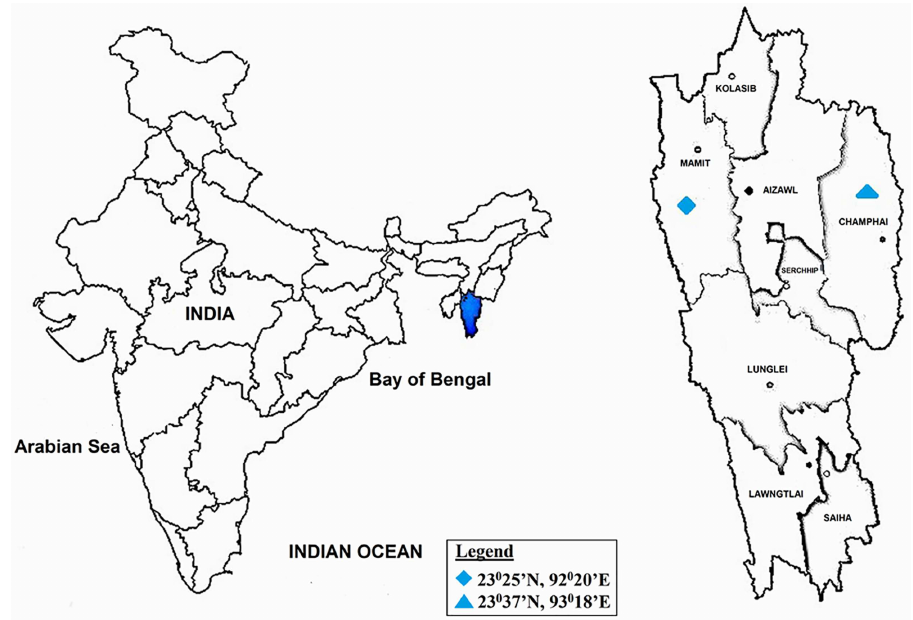
Fig 1. Map revealedthe locations of the Sub-tropical Semi-evergreen forest ecosystemssampling sites of Dampa TR and Murlen NP, Mizoram, India.